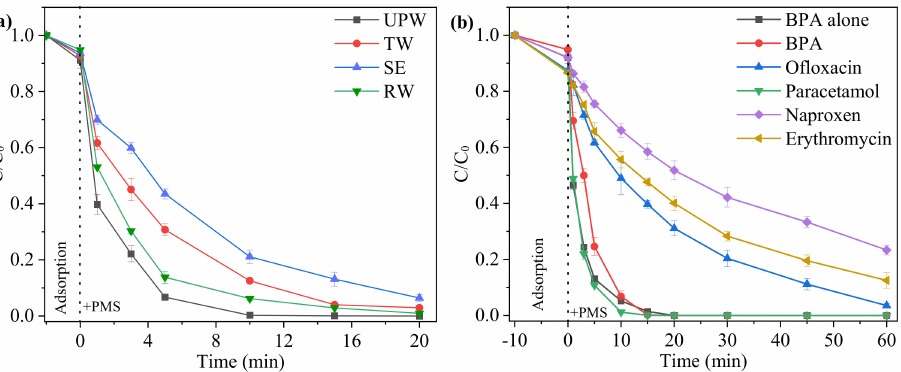
Figure 5. Degradation of BPA ( a ) in different water matrices and ( b ) with various emerging or- ganics in the Mn 2 O 3 /PMS system. ( a ) Reaction conditions: [BPA] 0 = 10 mg/L, [PMS] 0 = 0.10 mM, [Mn 2 O 3 ] 0 = 0.2 g/L, initial pH = 7.0 ± 0.2. ( b ) Reaction conditions: [BPA] 0 = [Ofloxacin] 0 = [Paracetamol] 0 = [Naproxen] 0 = [Erythromycin] 0 = 5 mg/L, [PMS] 0 = 0.10 mM, [Mn 2 O 3 ] 0 = 0.2 g/L, initial pH = 7.0 ±